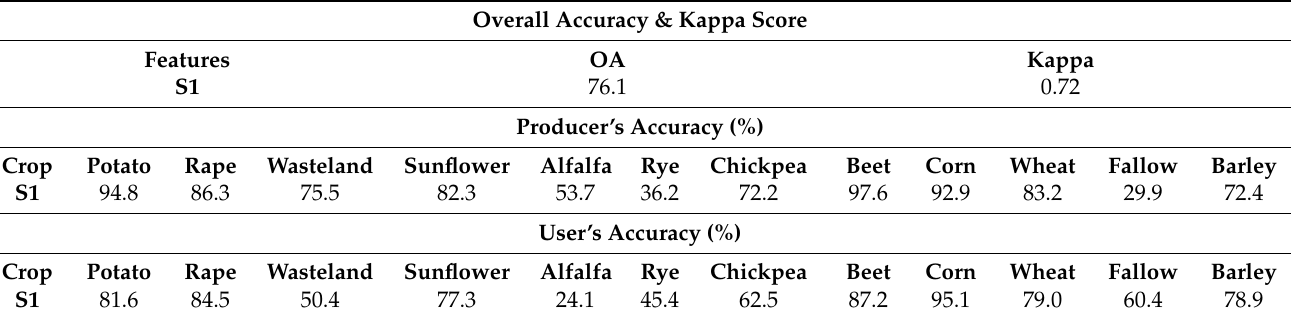
Table 5. Classification scores at pixel level with 40 Sentinel-1 images.